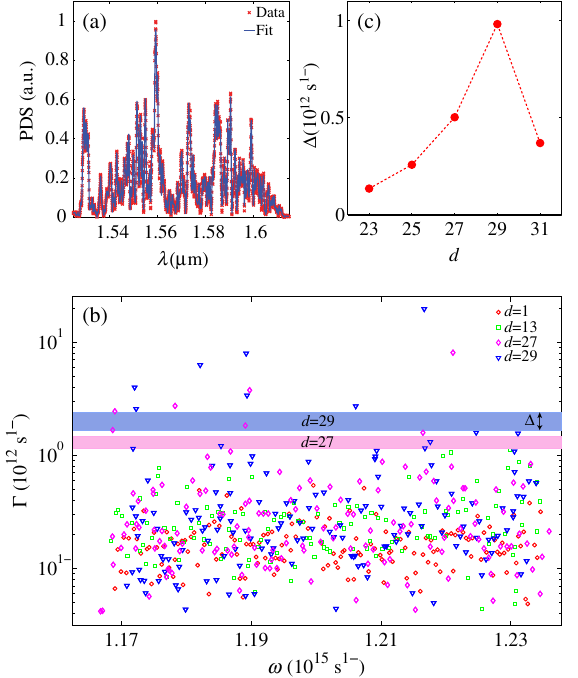
FIG. 2. (a) Experimentally measured power-density spectrum (PDS) (cross markers) and theoretical reconstruction (solid line) via wavelet multiscale analysis for different waveguide spacings d . (b) Experimentally extracted resonance ð ω ; Γ Þ distribution for different output waveguide spacings d . (c) Experimentally measured gap width Δ , which separates superradiant states from long-living resonances, versus d